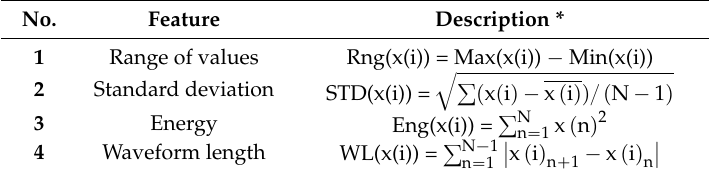
Table 1. Feature sets computed from both piezoelectric and accelerometer sensor epochs. No.